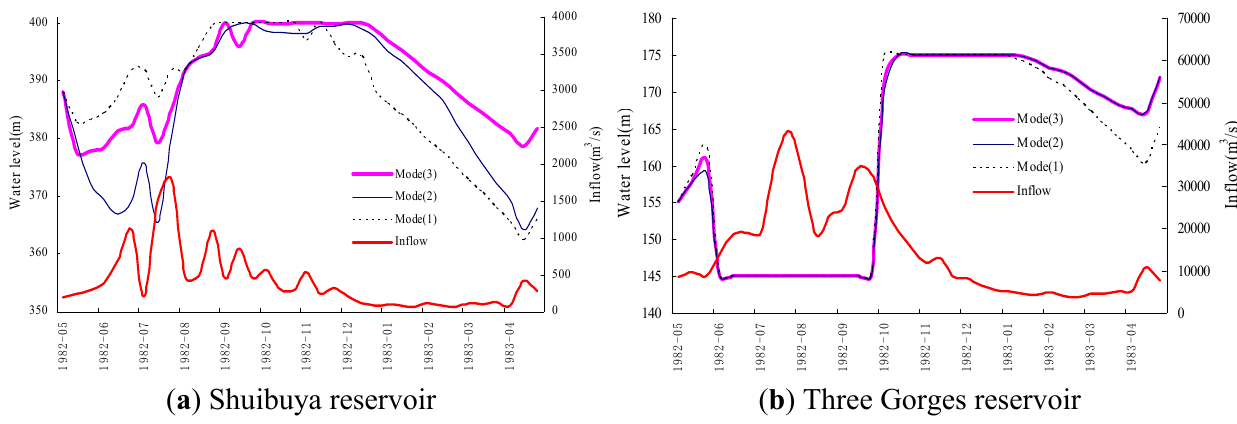
Figure 8. Comparison of water levels for three operation modes (wet